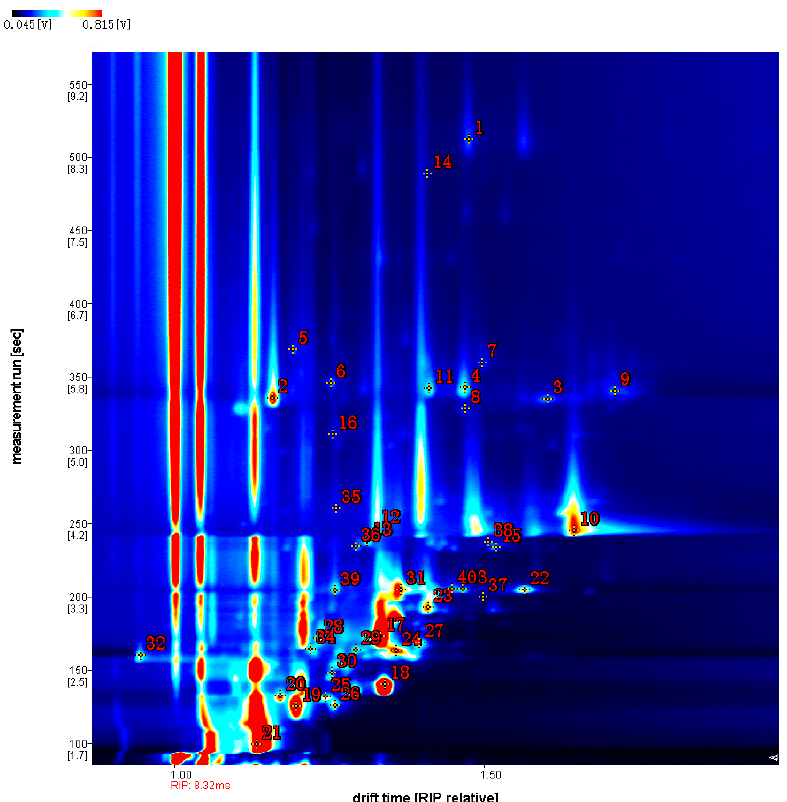
Figure 12. The 2D GC-IMS chromatogram of volatile organic compounds in crucian carp muscle, after treatment with vanillin. The numbers correspond to the identities in Table 4. Volatile organic compounds were identified from crucian carp muscle, after treatment with vanillin.